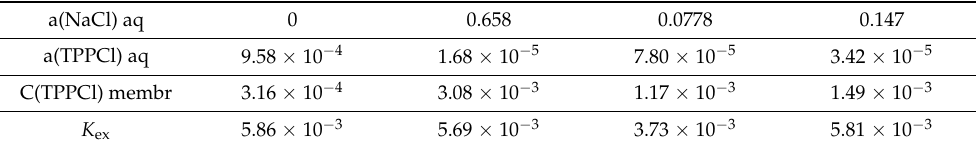
Table A3. The equilibrium TPPCl concentrations in the membrane phase, activities in water solution, and calculated values of coextraction and association